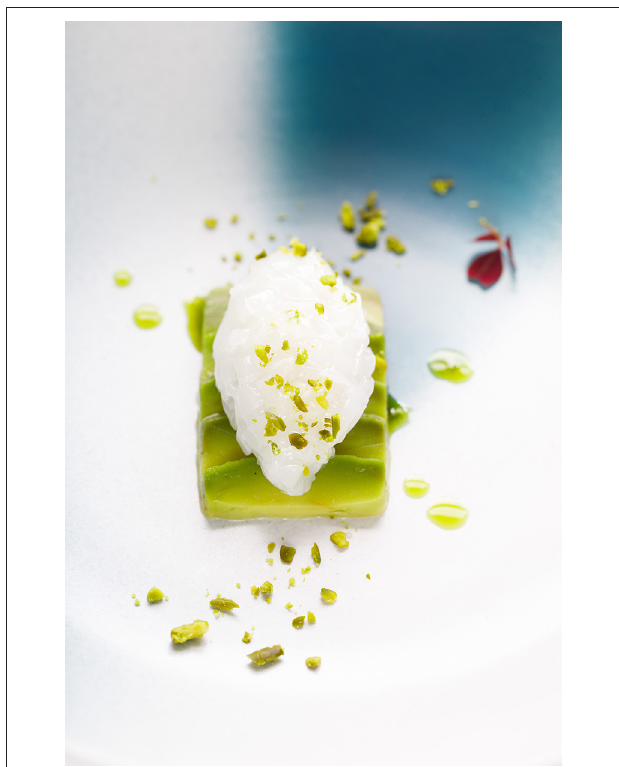
FIGURE 4 | A novel dish of tartare made of Sepia officinalis with pistachio, lime, and avocado. Photo: permission by and courtesy of Jonas Drotner Mouritsen.